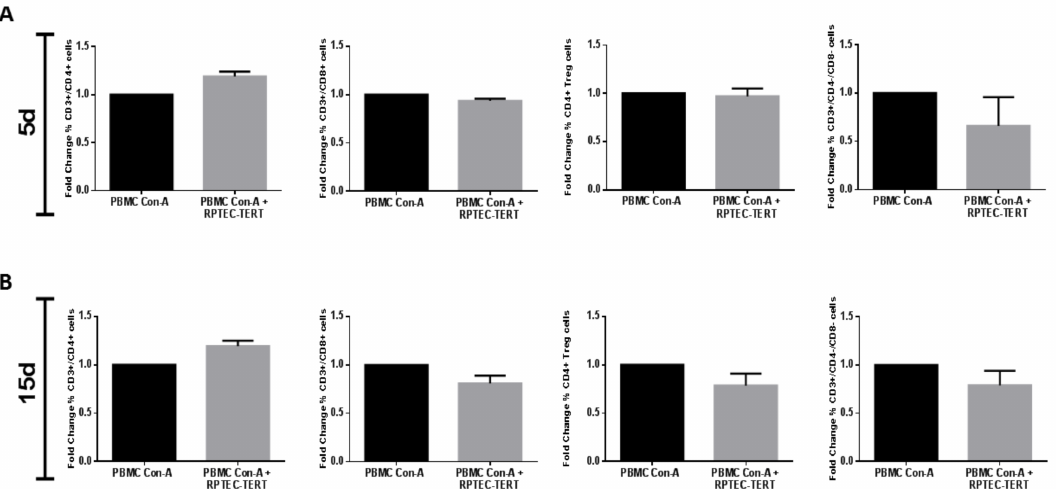
Figure 4. The immunomodulation effect was specific for ARPCs. No significant changes in the % of T cell subsets were observed when ConA activated PBMC were co-cultured with RPTECs for 5 ( A ) or 15 days ( B ). Data represent the fold change of the PBMC percentage with respect to PBMC Con-A. Data are representative of three independent experiments (means ±